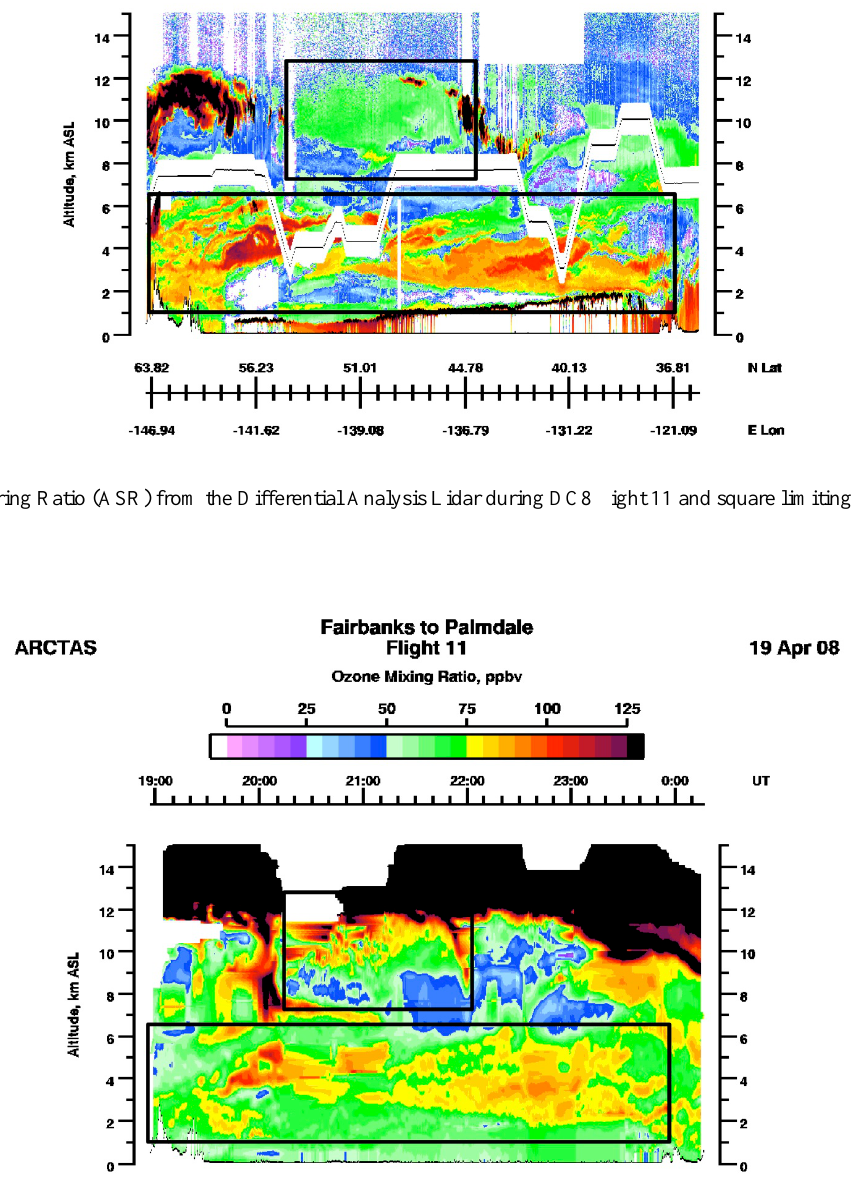
) mixing ratio. The rectangles indicate the 3